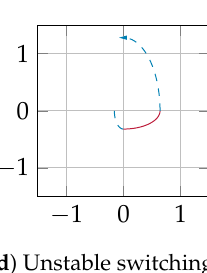
Figure 1. Switching between stable